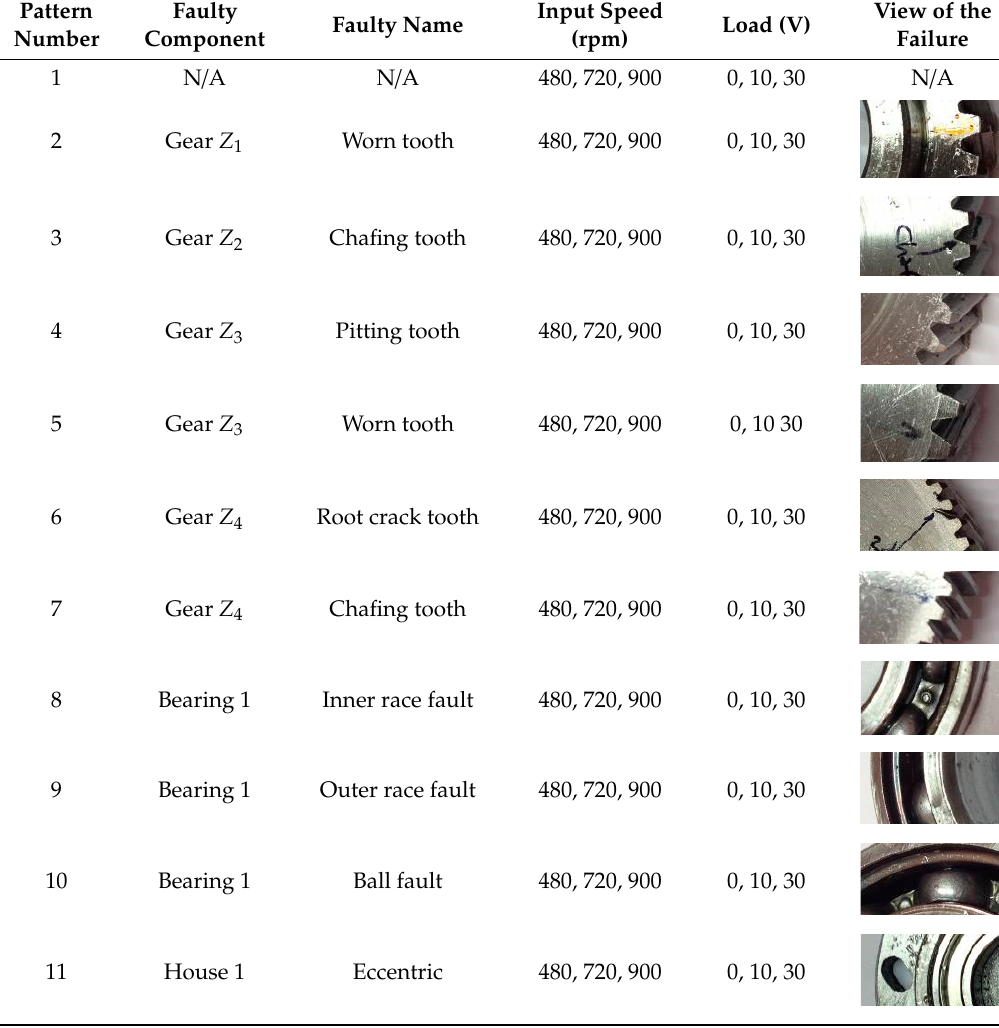
Table 2. Condition patterns of the gearbox.